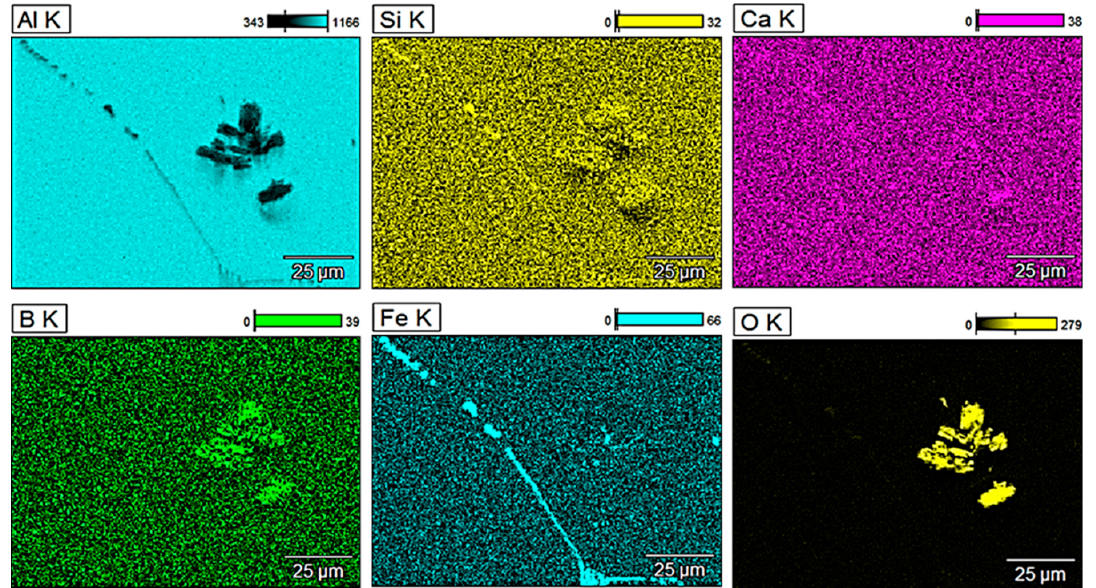
Figure 4. EDX mapping of EN AW 1370 with 1 wt.% of GF reinforcement (metallurgical synthesis).